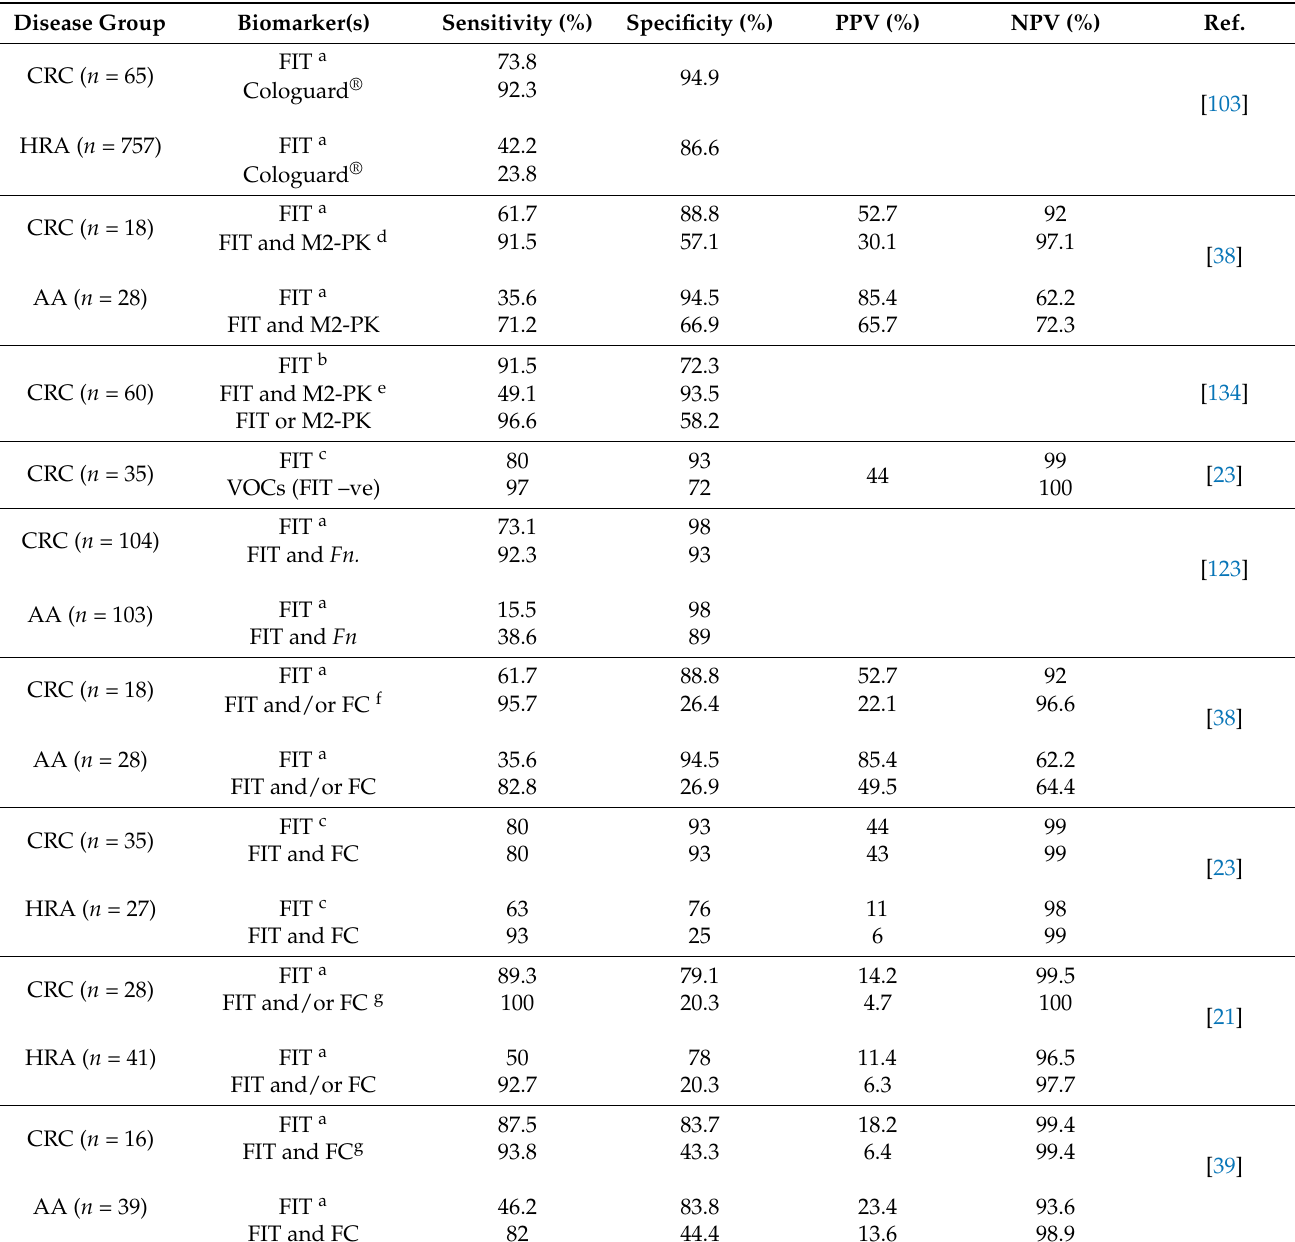
Table 4. Diagnostic performance of biomarker combination for CRC and high-risk/advanced